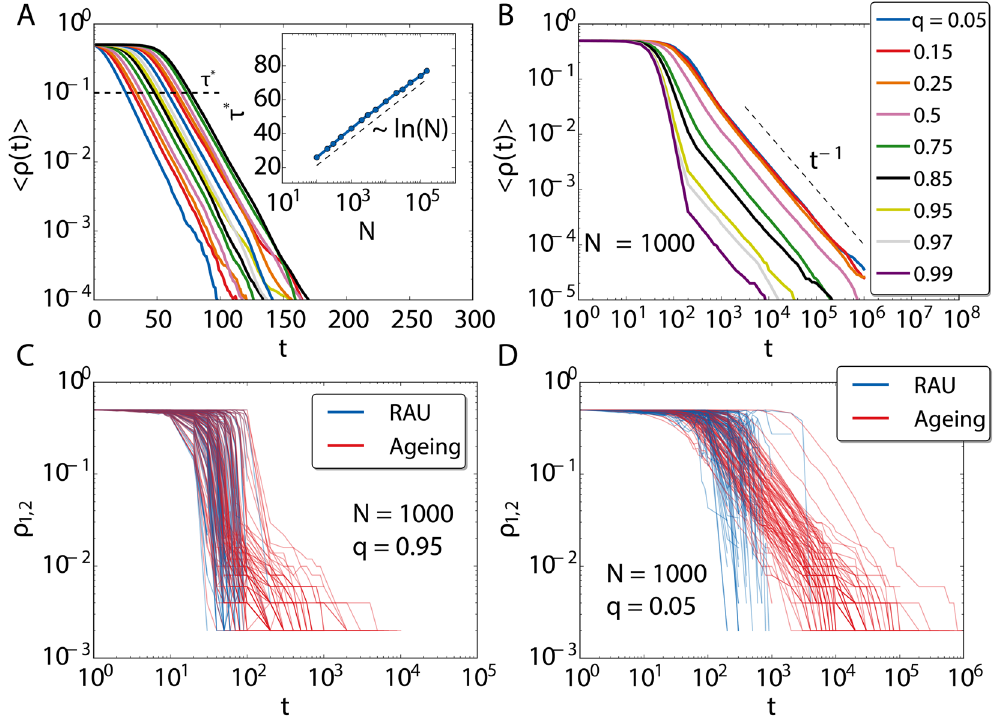
Figure 8. Mixed updates on two complete graphs forming a partial multiplex, one layer with endogenous update ( b = 1) and the other with RAU. In ( A ) average fraction of active links as a function of time for different system sizes N , for q = 1. In the inset, the time to cross τ * = 10 − 1 as a function of N . In ( B ) average fraction of active links as a function of time for different values of q ; the system size is N = 1000. Averages over 1000 simulations. In ( C , D ) 2 × 100 individual trajectories for q = 0.05 and q = 0.95, respectively. The density of active links is separated by layer, showing in red the one with ageing and in blue is the one with